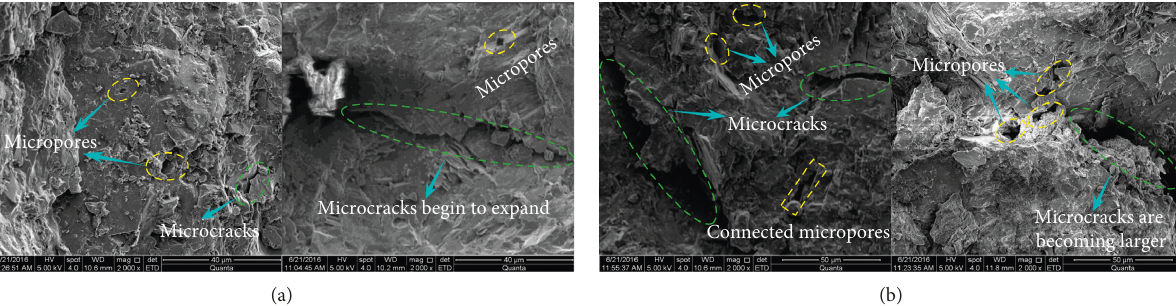
Figure 6: Scanning electron microscope of samples under different freeze-thaw cycles (0, 20, 40, and 60).